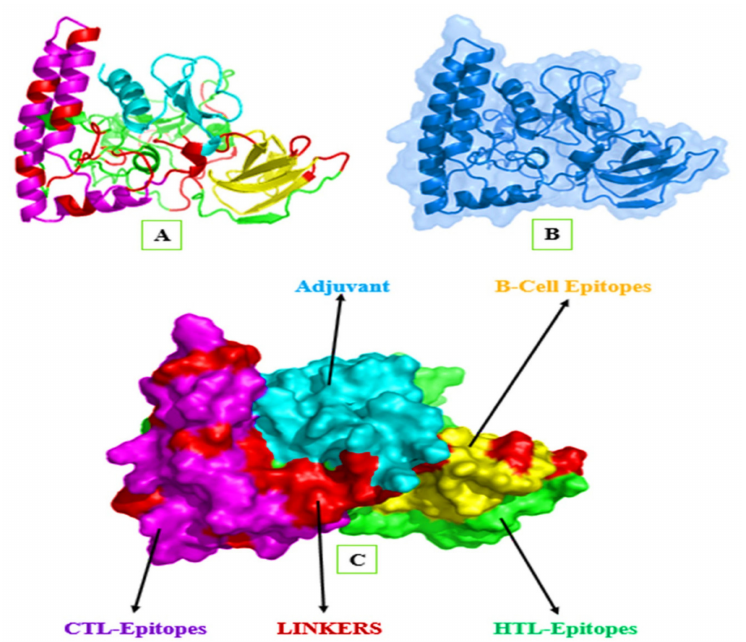
Figure 4. Visualization of the 3D structure of the proposed immunogen. Panel ( A ) multi-epitope immunogen presented in distinctive colors, where (cyan color) shows adjuvant, (magenta color) shows CTL epitopes, (green color) shows HTL epitopes, (yellow color) shows BL epitopes, and (red color) shows the different linkers (AAY, GPGPG, and EAAAK). Moreover, in Panel ( B ) (marine color) shows a cartoon representation with 80% surface transparency, while Panel ( C ) shows the complete (100%) surface shape of the multi-epitope immunogen subunits, indicated by different